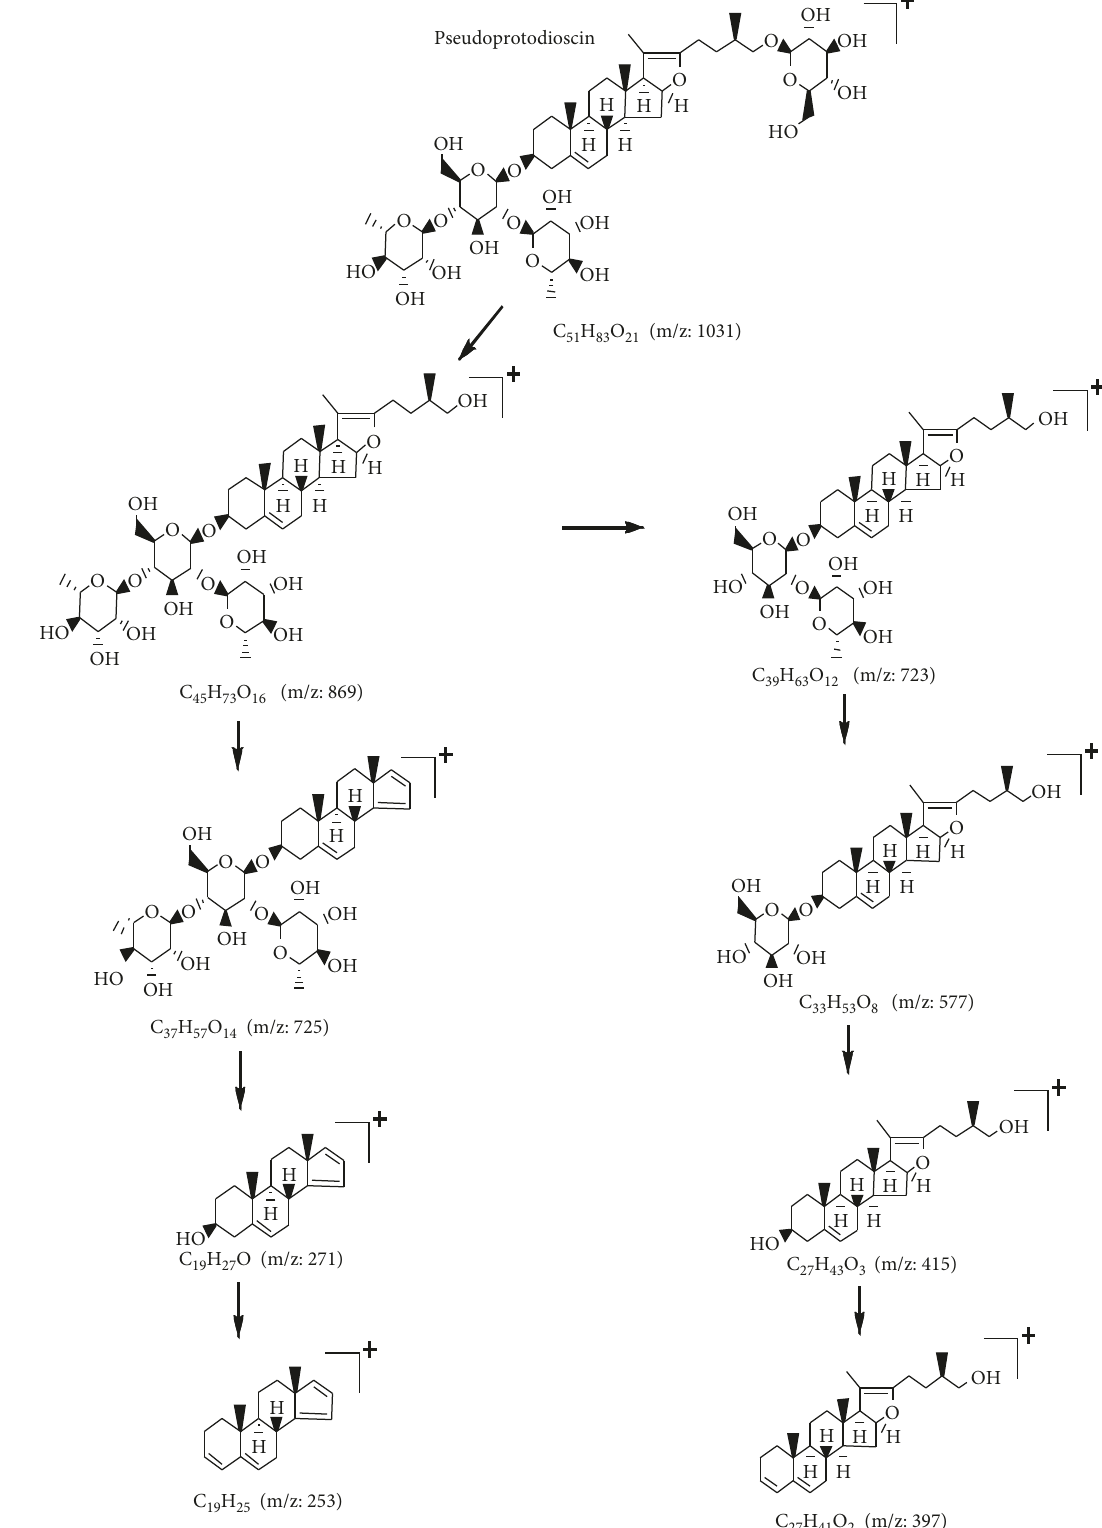
Figure 6: Fragmentation pathway of